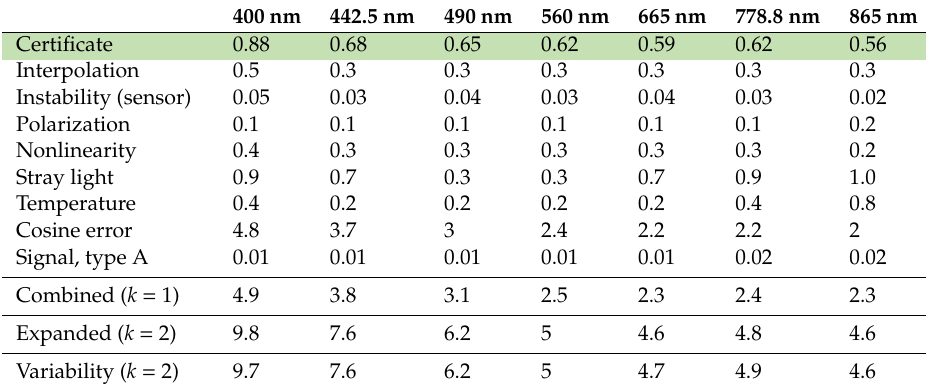
Table 4. Relative uncertainty budget for the downwelling irradiance (in percent), based on the spread of individual sensors measuring the same target during the outdoor comparison. Data highlighted in green are not used for combined and expanded uncertainties. Last row: Relative experimental variability of sensors evaluated from the results of field comparisons.